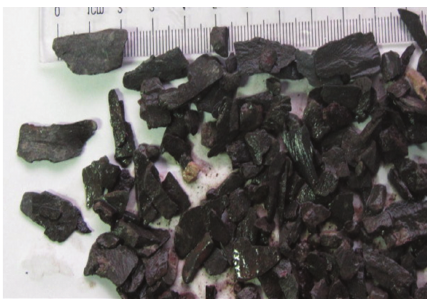
Figure 3: The shale cavings of the Nahr Umr Shale of N006H